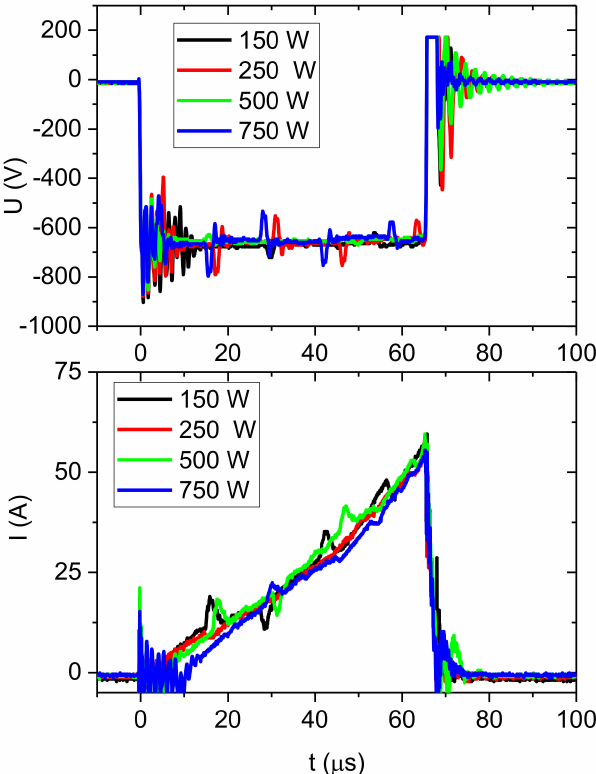
Figure 1. Electrical characteristic of the pulses used for deposition of Copper in HiPIMS mode at different average power and same peak current of ~60 A.